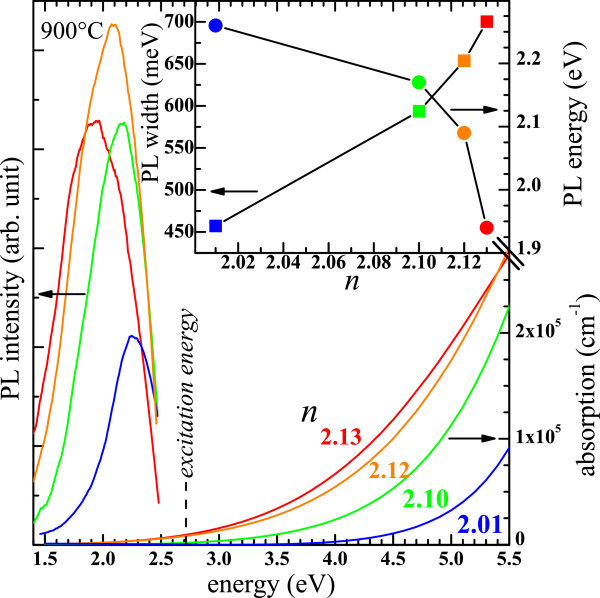
Variations of the PL and the absorption spectra with the refractive index n. The inset shows the evolution of the peak position and the band width with n.